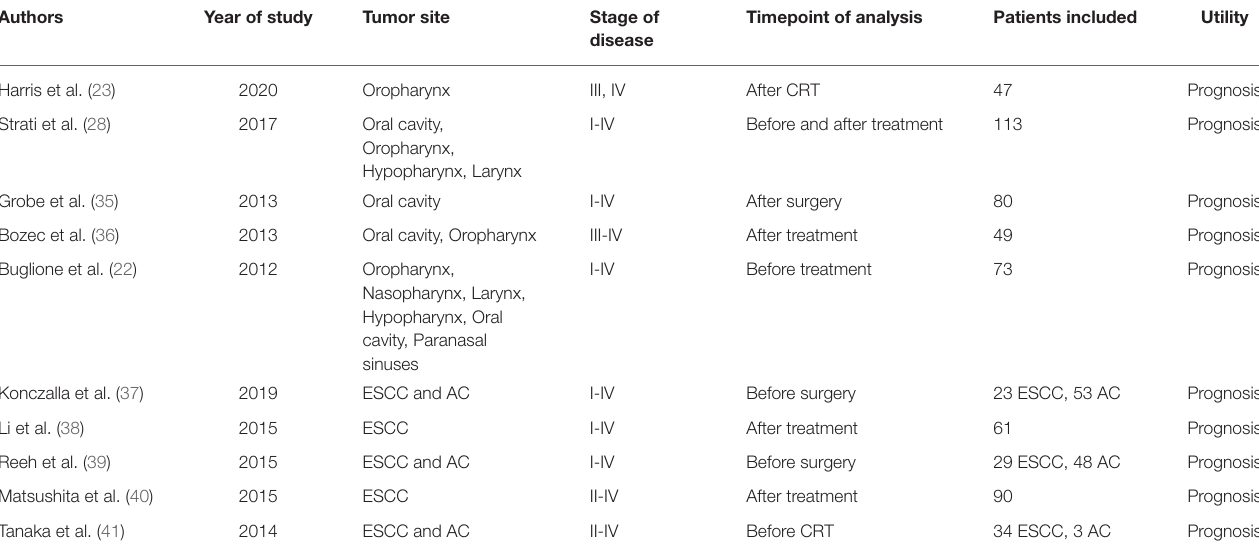
TABLE 1 | Studies on circulating tumor cells in head and neck squamous cell carcinoma (HNSCC) and esophagus squamous cell carcinoma (ESCC) using CellSearch